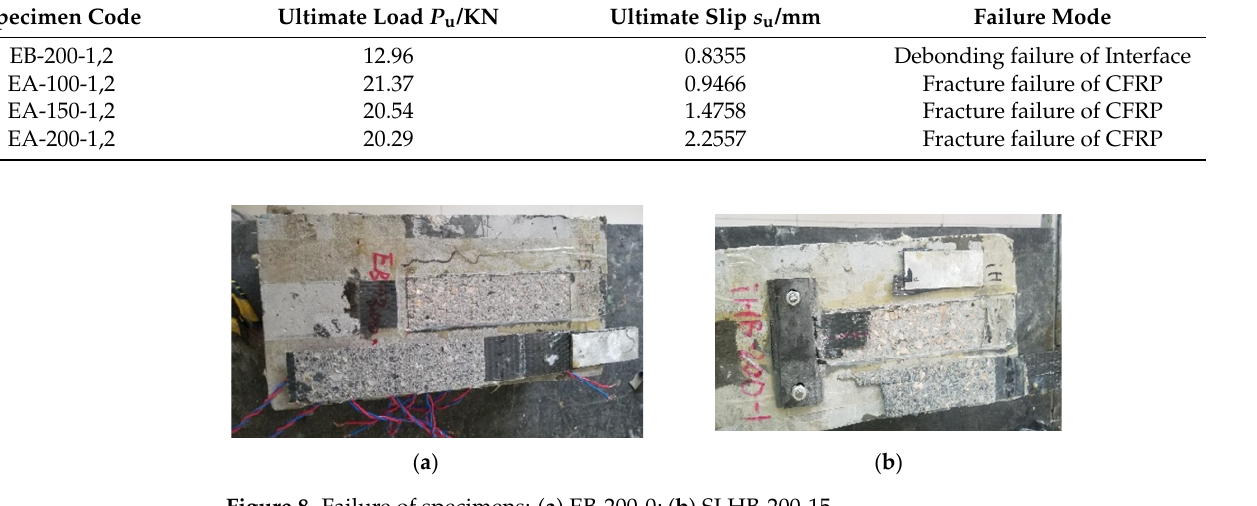
Figure 8. Failure of specimens: ( a ) EB-200-0; ( b ) SLHB-200-15.